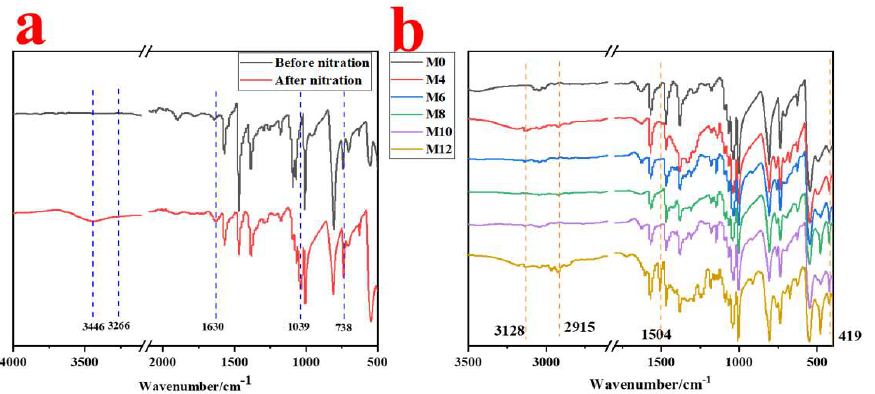
Figure 3. ( a ) FT-IR spectra of PPS non-woven fabrics before and after treatment with nitric acid solution; ( b ) FT-IR spectra of ZIF-8/PPS fiber membranes obtained after different ZIF-8 in situ growth times (M0: untreated; M4: 4 h; M8: 8 h; M10: 10 h; M12: 12 h).